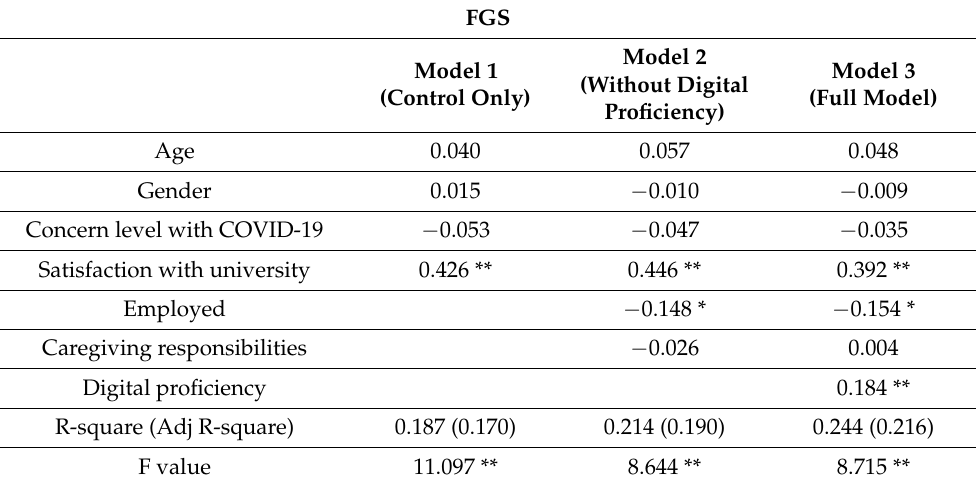
Table 4. Regression on psychological well-being (FGS).